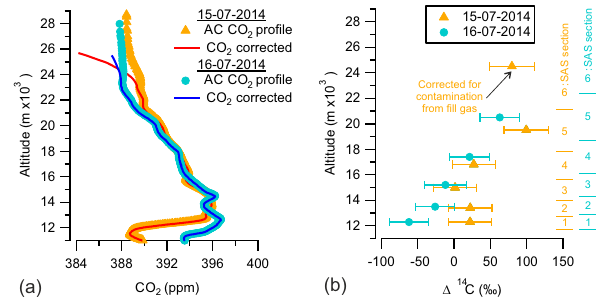
Figure 6. (a) AirCore (AC) CO 2 profiles (orange triangles for 15 July 2014 and cyan circles for 16 July 2014) and their correspond- ing corrected AirCore CO 2 profiles (red line for 15 July 2014 and blue line for 16 July 2014). (b) The (cid:49) 14 C values (‰, orange trian- gles representing samples from 15 July 2014 and cyan circles repre- senting samples from 16 July 2014) in each section of the SAS. The last CO 2 sample extracted from the AirCore sampled on 16 July 2014 was lost. The uncertainties in the (cid:49) 14 C values correspond to measurement uncertainties arising from limited counting